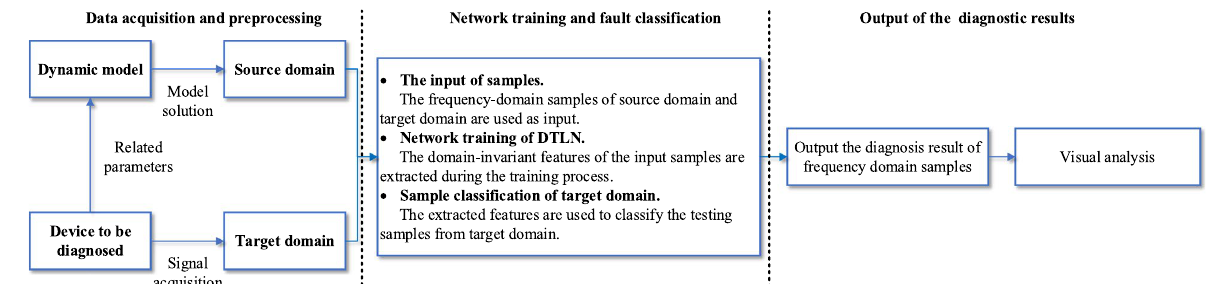
Fig. 4 Fault diagnosis framework of the proposed method